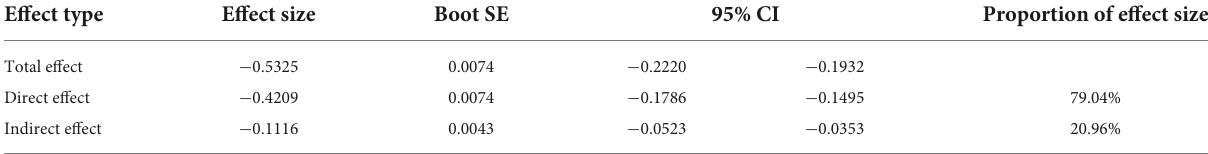
TABLE 3 The mediating role of self-control in the relationship between perceived social support and depression.